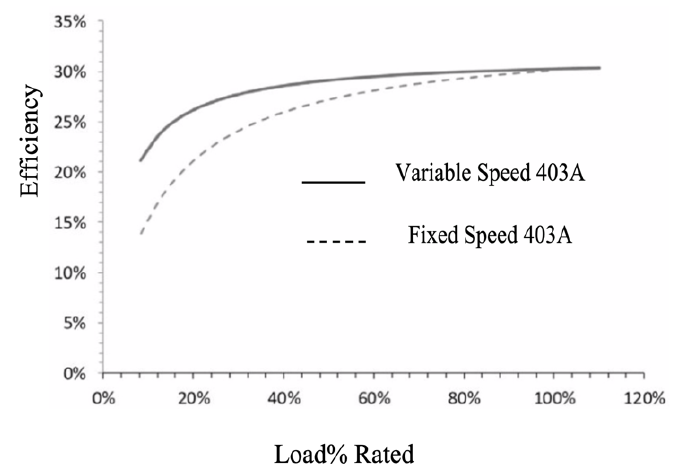
Figure 2. Fix speed vs. variable speed performance [10].